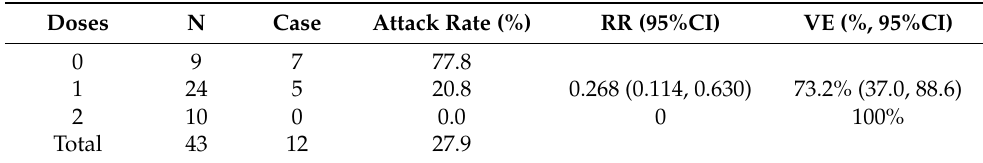
Table 3. Varicella attack rate and vaccine effectiveness by number of doses of varicella